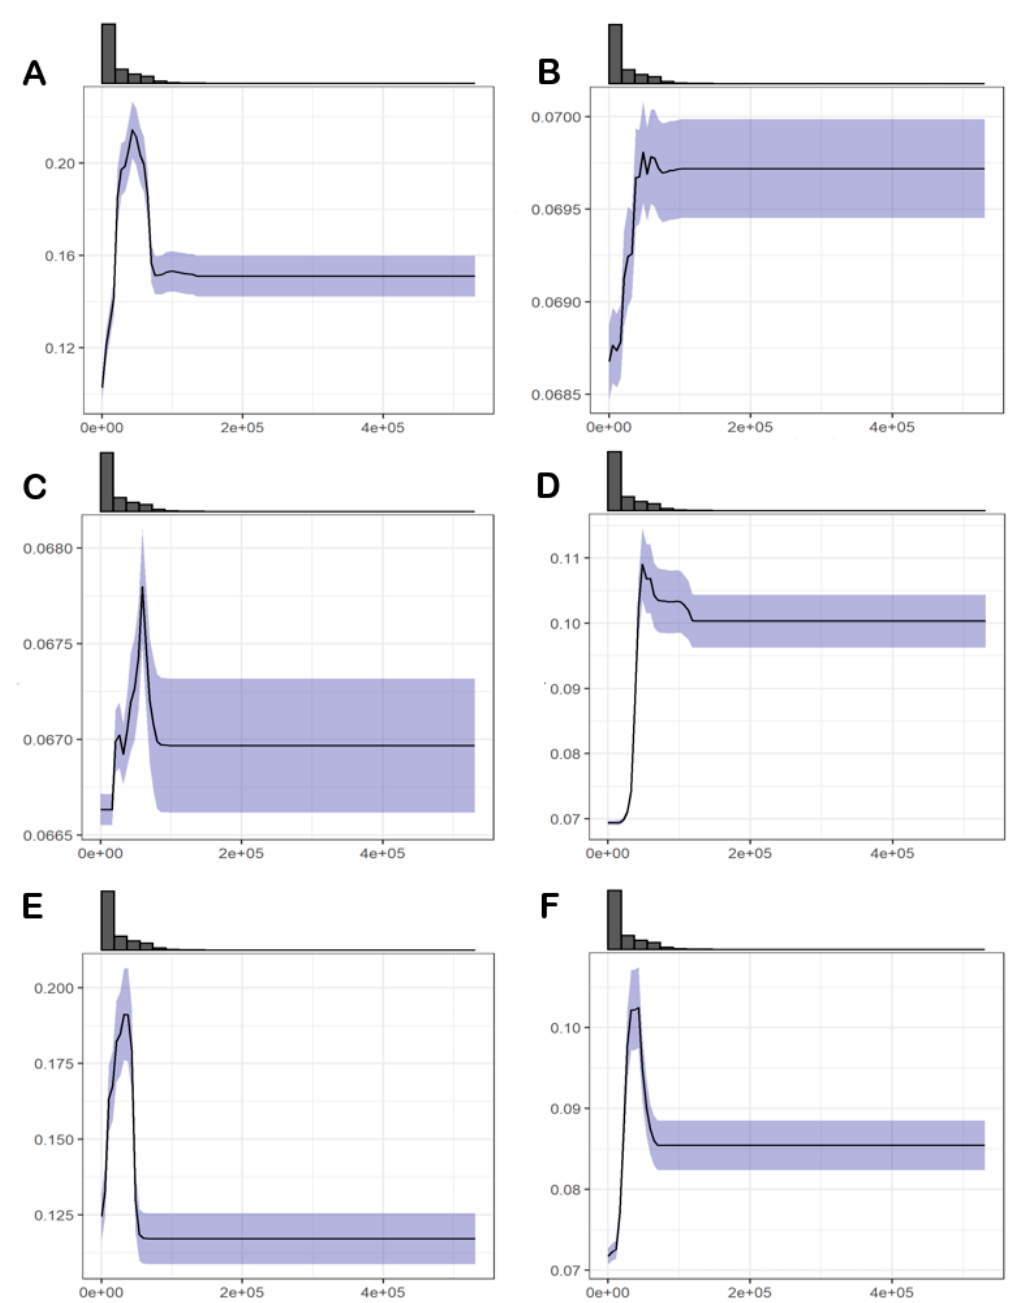
Figure A4. Response curves (average of all GBM models ± ½ std.-deviation) showing habitat suitability variation as function of tree density, for ( A ) MSD, ( B ) PRC, ( C ) T. lusitanica , ( D ) T. ebejeri , ( E ) T. semiaptera and ( F ) T. iberica .